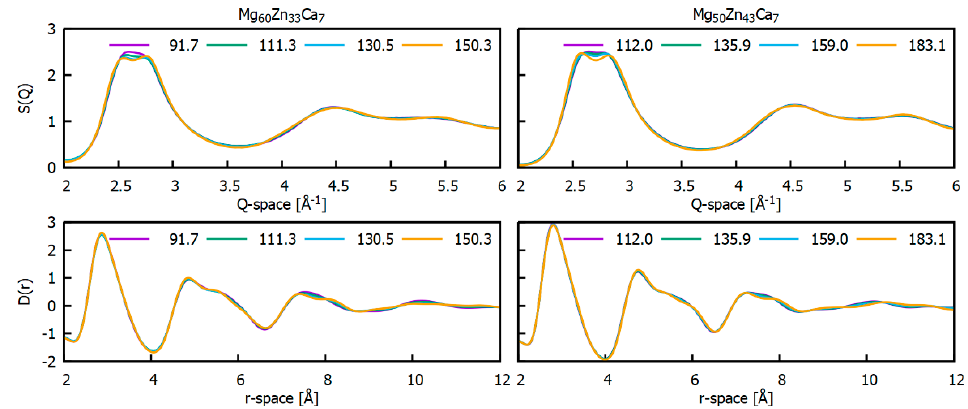
Figure 6. Selected structure factor and corresponding reduced pair distribution functions, S ( Q ) and D ( r ), collected at different temperatures during a first crystallisation event.